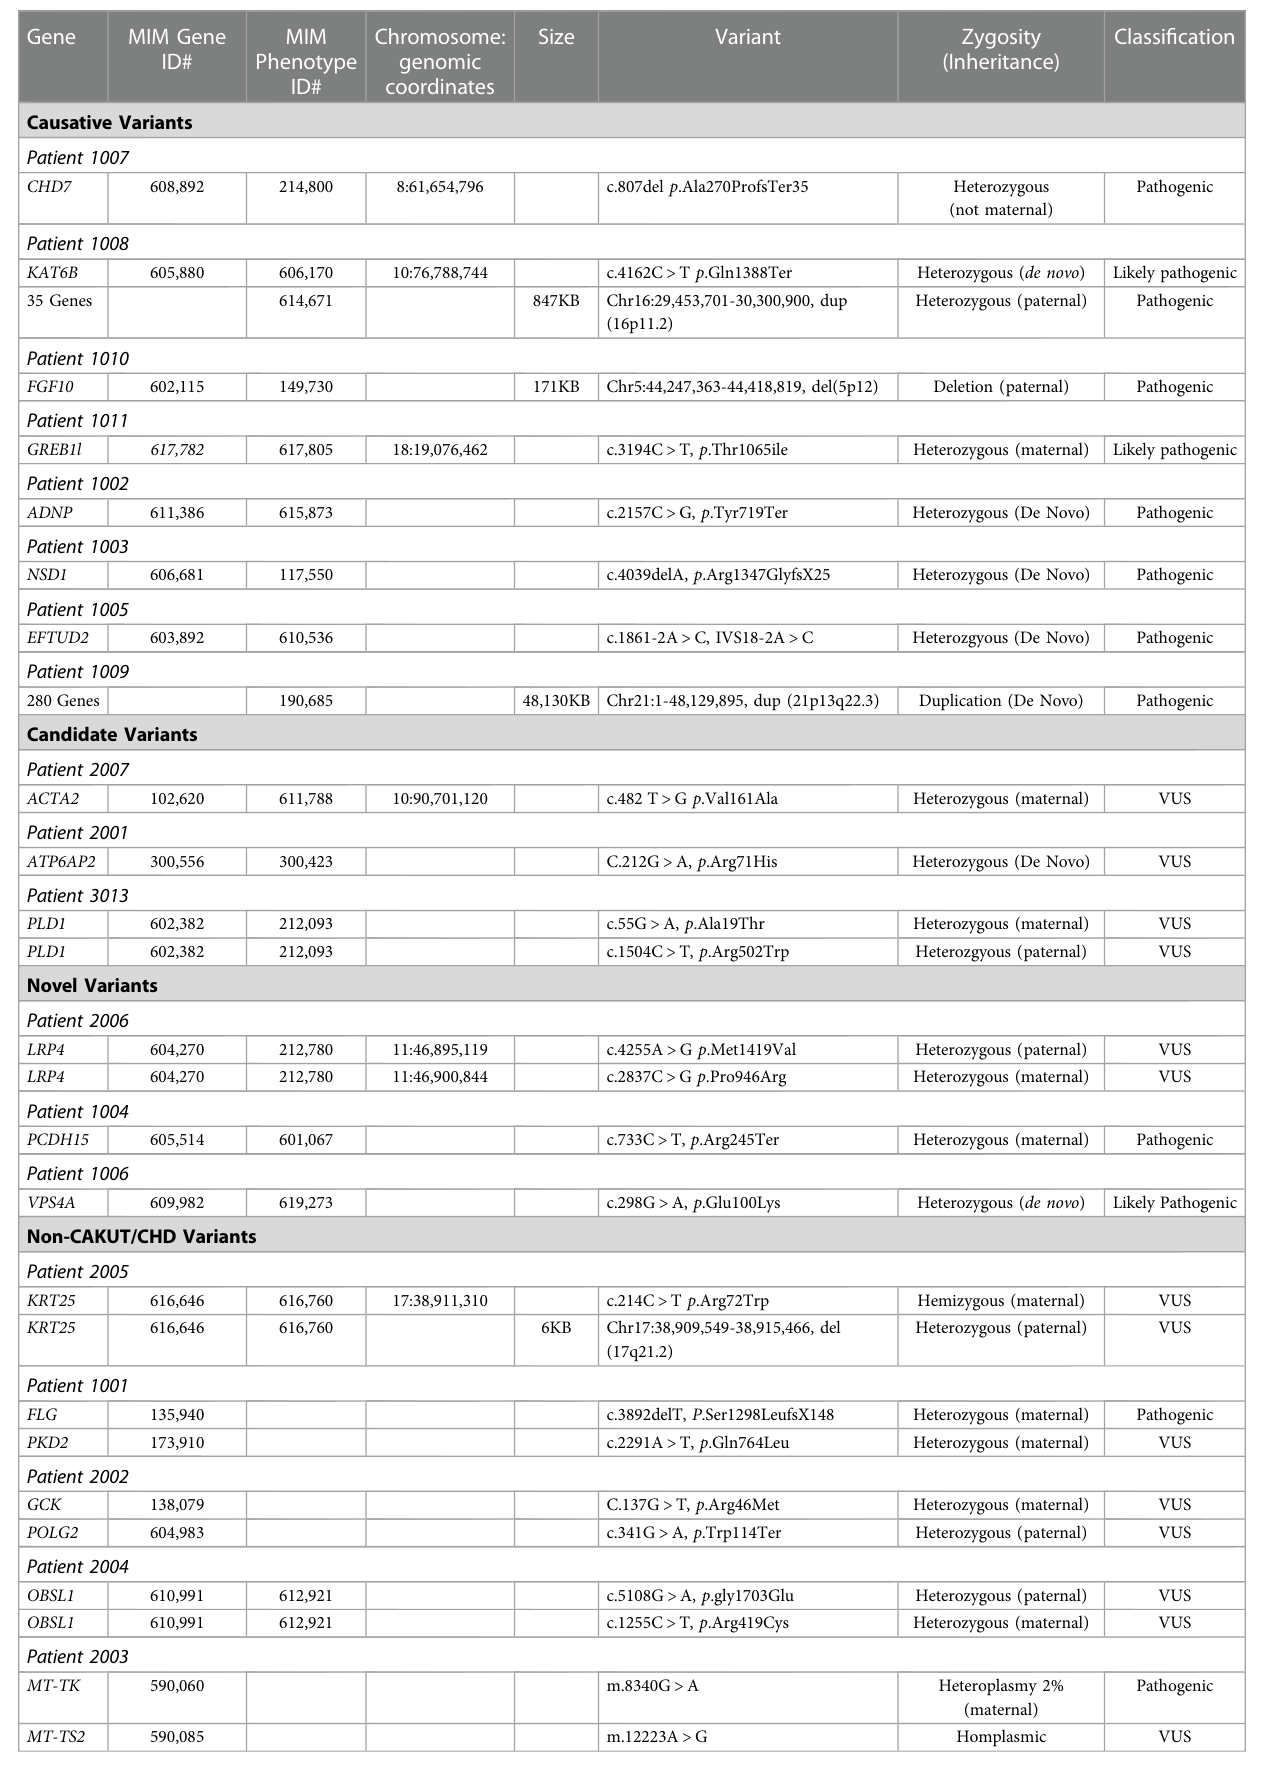
TABLE 2 Identi fi ed variants via